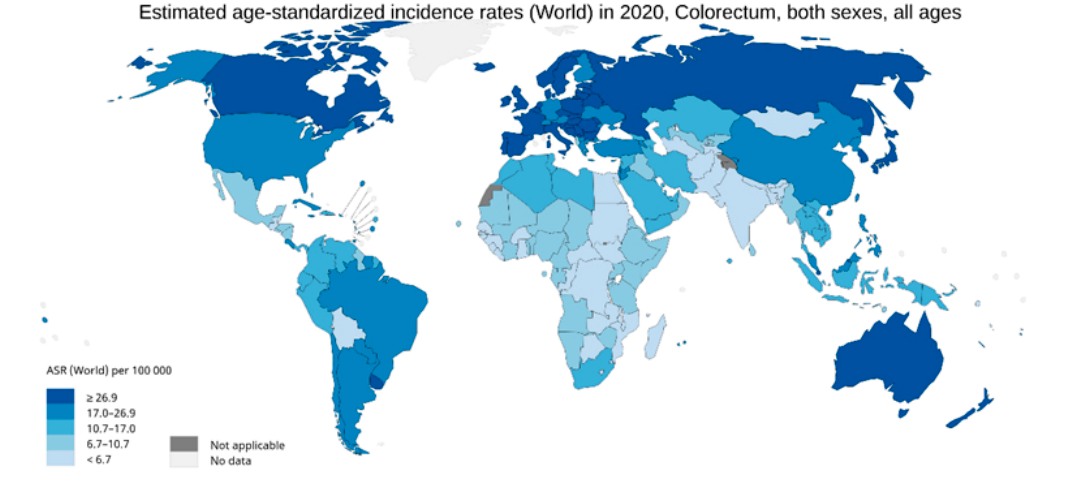
Figure 1. Estimated age-standardized incidence rates (World) in 2020, colorectal carcinoma, both sexes, all ages. Available at: https://gco.iarc.fr/today (accessed on 17 December 2021) [2–4].